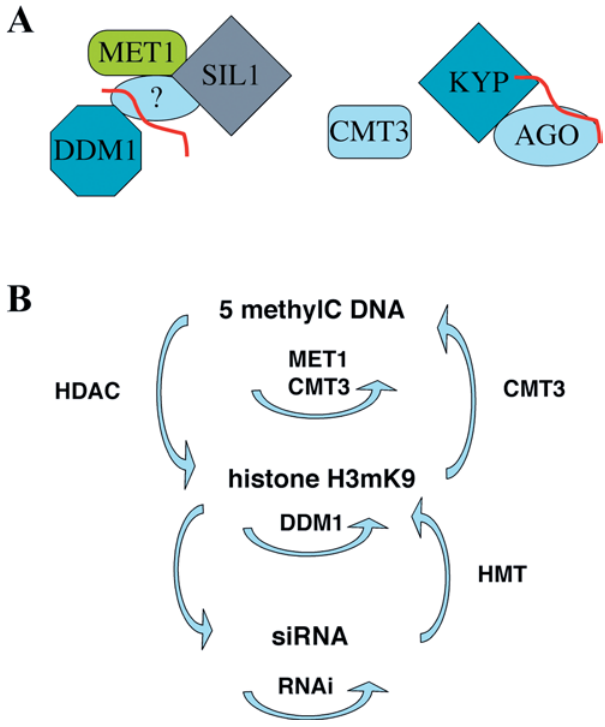
Figure 5. Model of Transposon Silencing Complexes (A) DDM1, MET1, and SIL1 are all required for transposon silencing and may interact. MET1 and DDM1 are also required for siRNA accumulation (shown in red). AGO and KYP have similar effects on transposon activation and may also interact. They impact DNA methylation via CMT3 (Cao and Jacobsen 2002; Jackson et al. 2002). (B) siRNA, histone H3 methylation, and DNA methylation interact to silence transposons. Silencing is maintained by the MET1/DDM1/SIL1 complex. A possible network is shown.